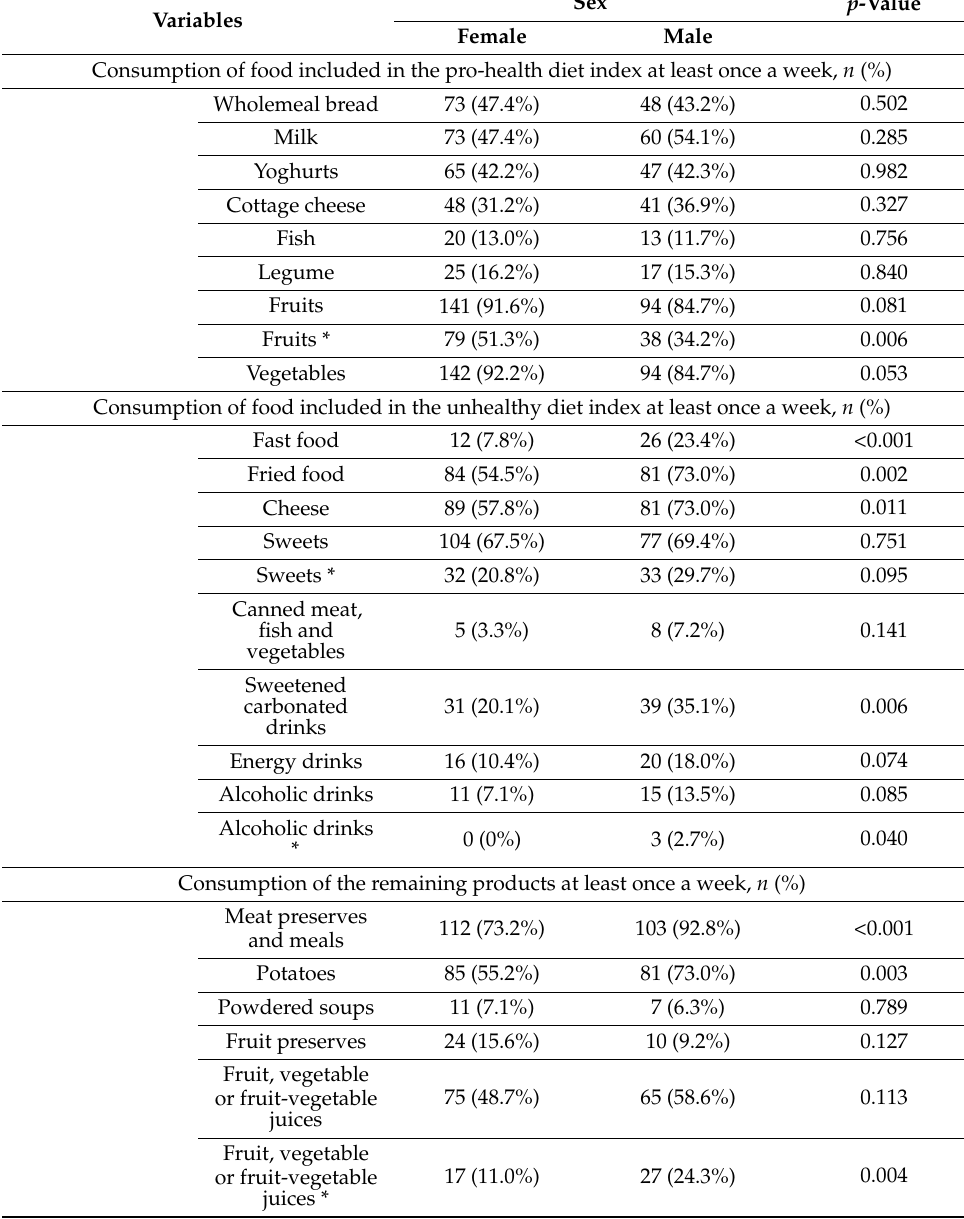
Table 2. Women and men’s food consumption